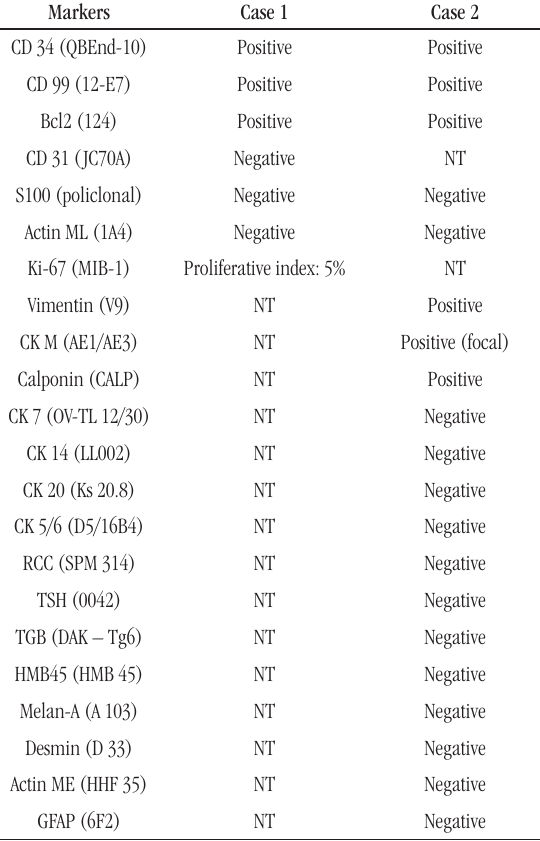
figurE 1 – Computed tomography without contrast, showing a single, well- defined nodular lesion, that is hypodense in relation to muscle and left false fold space-occupying